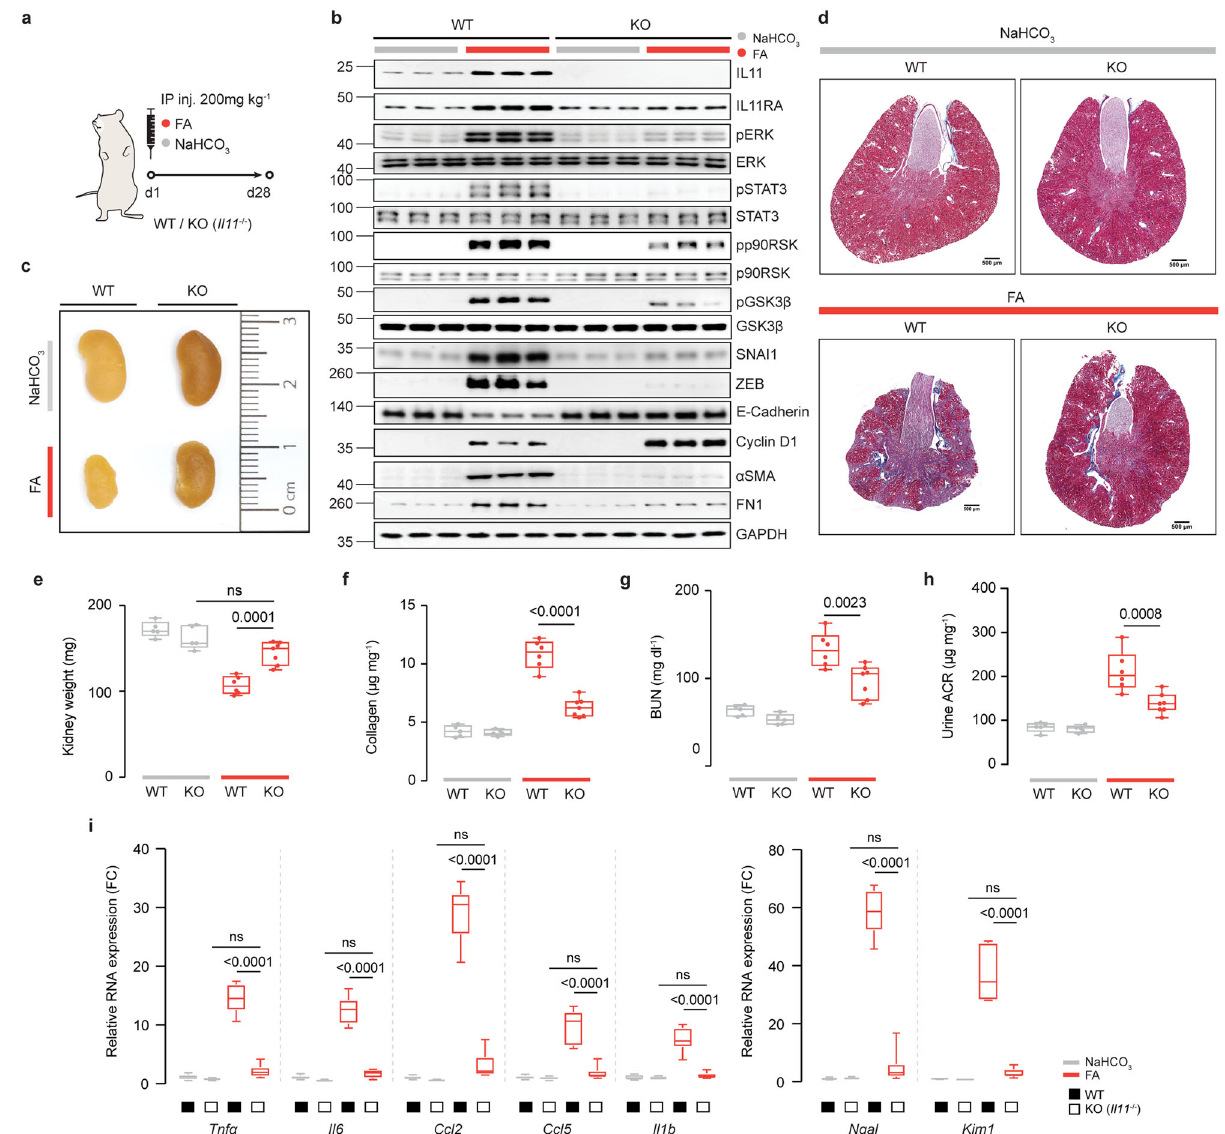
datasetfrom n =5/group), c representativekidneygrossanatomy, d representative Masson ’ s Trichrome images of whole albumin-to-creatinine ratios (ACRs), and i relative renal mRNA expression of kidney injury markers ( Ngal , Kim1 ) and pro-in fl ammatory markers ( Tnf α , Il6, Ccl2 , Ccl5, Il1 β ). e – i Data are shown as box-and-whisker with median (middle line), 25th – 75th percentiles (box), and minimum – maximum values (whiskers); WT-NaHCO 3 , Il11 − / − -NaHCO 3 ( n =5/group), WT-FA ( n =6), Il11 − / − -FA ( n =7); two-way ANOVA with Sidak ’ s correction. FC: Fold change. Source data are provided as a Source data fi